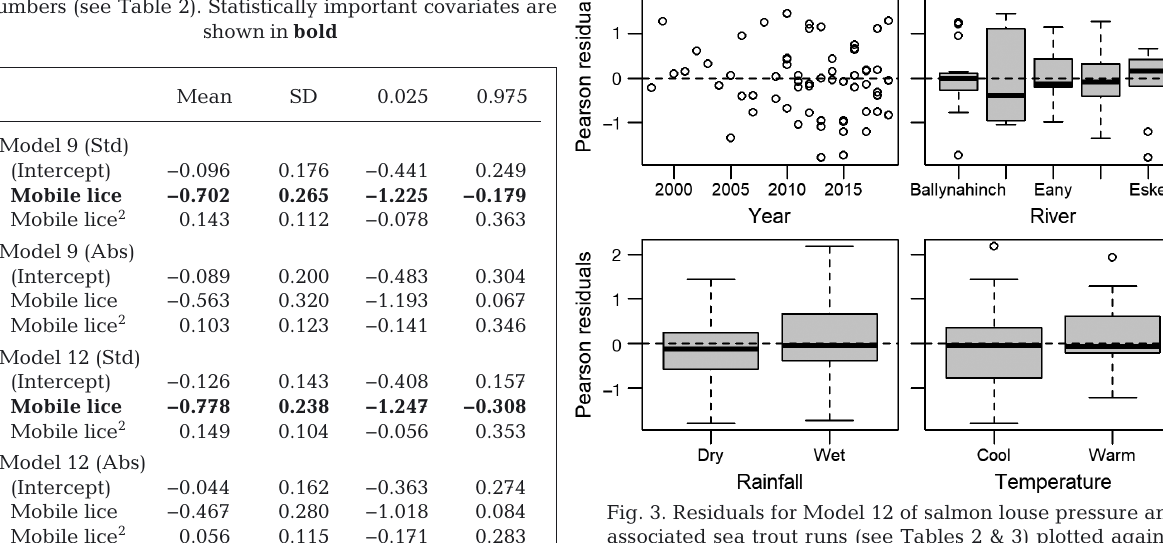
Table 3. 95% credible intervals for parameters of the se- lected models of salmon louse pressure and associated sea trout runs. Results are shown for the models including sea louse pressure standardised by river (Std) and absolute (Abs)